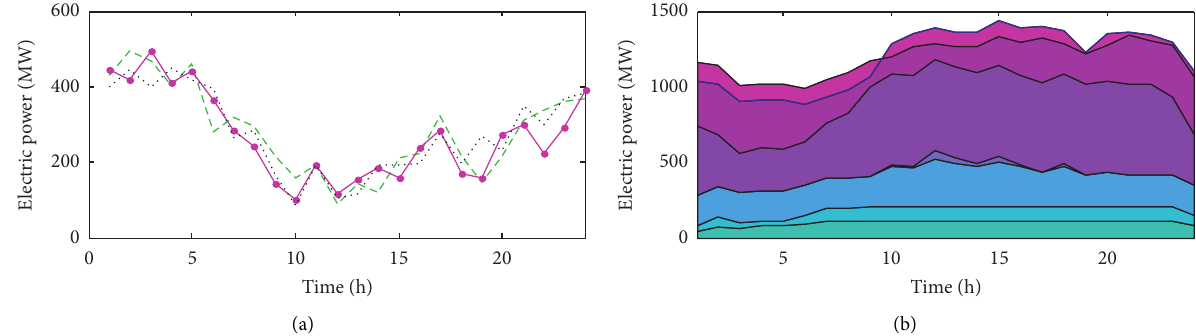
Figure 3: Day-ahead scheduling results: (a) wind scenarios; (b) average scheduled power of different resources.